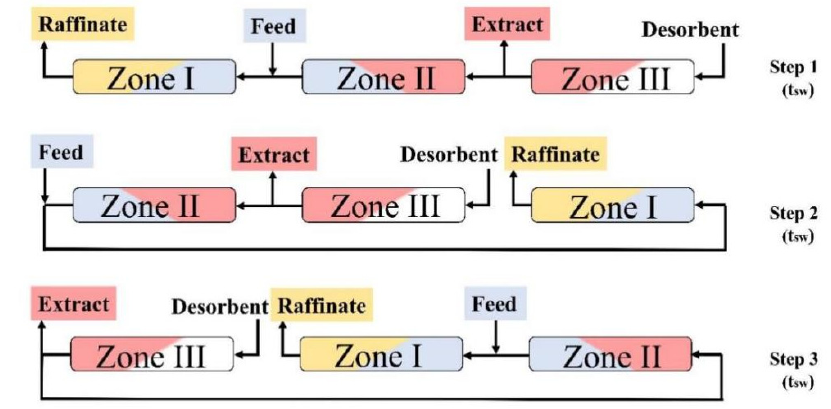
Figure 6. Standard three-zone SMB with three-step.